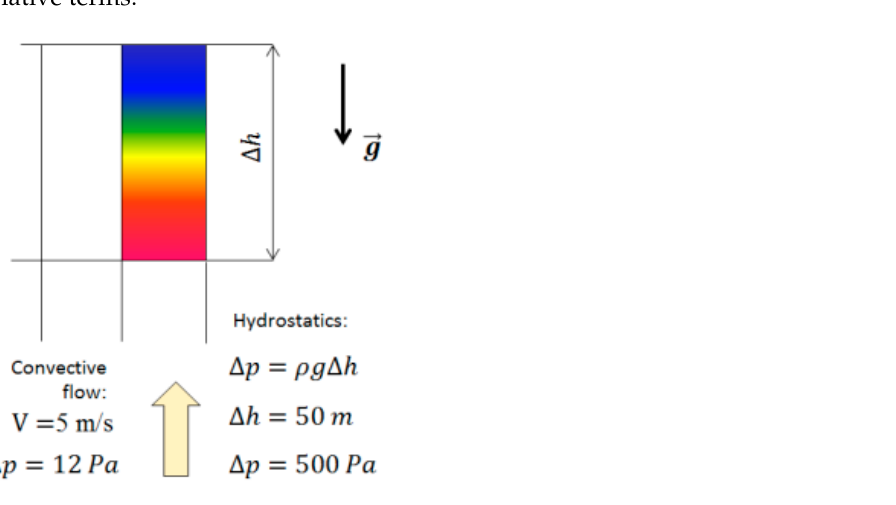
Figure 6. Illustration for the description of the specifics of the numerical solution of atmospheric problems.